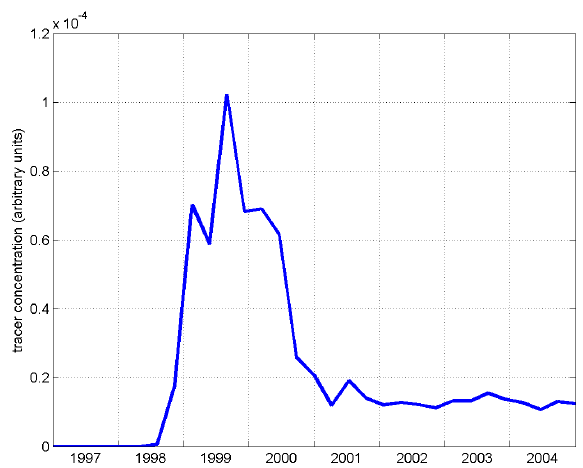
Fig. 9. Time series of passive tracer concentration at the OCCAM location of the overflow at the moorings, taken from the grid cell at location marked ‘X’ in Fig. 2c. Passive tracer was initialised at the surface in January 1997, and instantaneously released across the boxed region in Fig. 8.